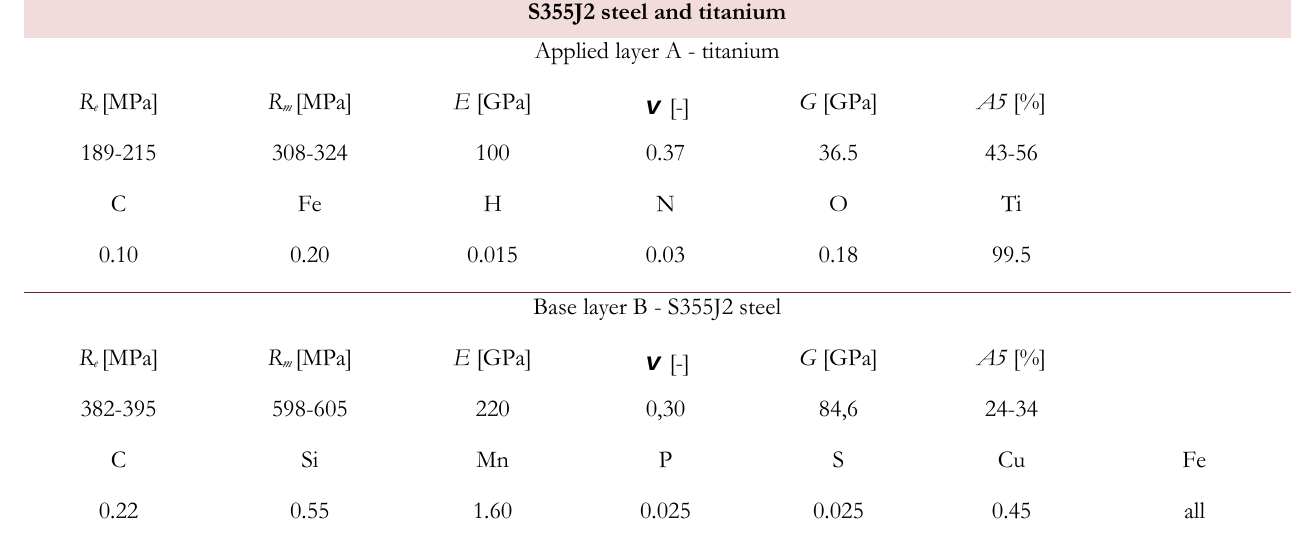
Table 1: Strength properties and chemical composition of S355J2 steel and titanium, where: R e – yield strength [MPa], R m –